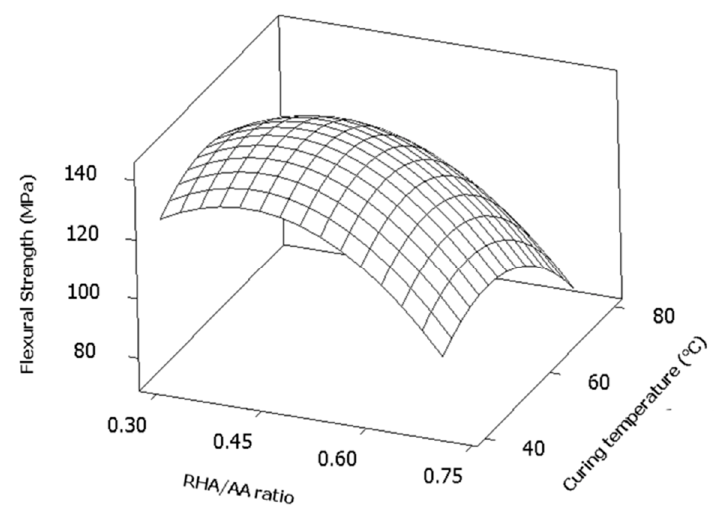
Figure 5. Surface plot of flexural strength vs. curing temperature and RHA/AA ratio.